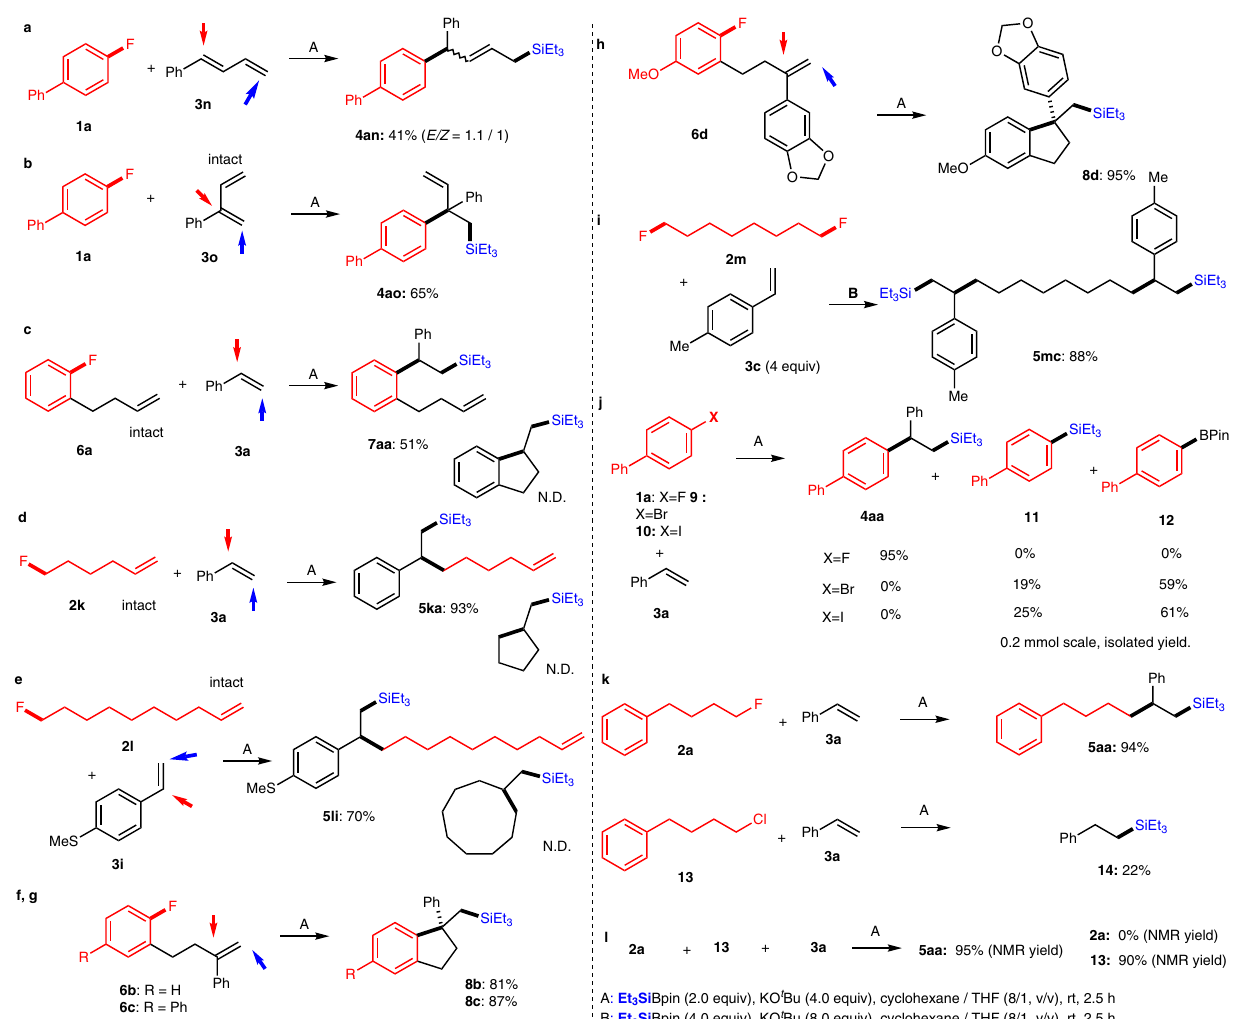
Fig. 4 Chemo- and site-selective coupling reactions. a Selective 1,4-type addition carbosilylation of 1,3-diene 3n . b Selective 1,2-carbosilylation of 1,3-diene 3o . c – e Selective three-component carbosilylation of styrenes ( 3a or 3i ) in the presence of an aliphatic alkene moiety in aryl fl uoride 6a or alkyl fl uorides 2k , or 2l . f – h Intramolecular carbosilylation of 6b – d to provide cyclized silylated products 8b – d . i Five-component carbosilylation of styrene 3c with 1,8- di fl uorooctane ( 2m ). j Comparisons of aryl halides ( 1a , 9 , and 10 ) for the carbosilylation. k Comparisons of alkyl halides ( 2a and 13 ) for the carbosilylation. l The competitive reaction between 2a and 13